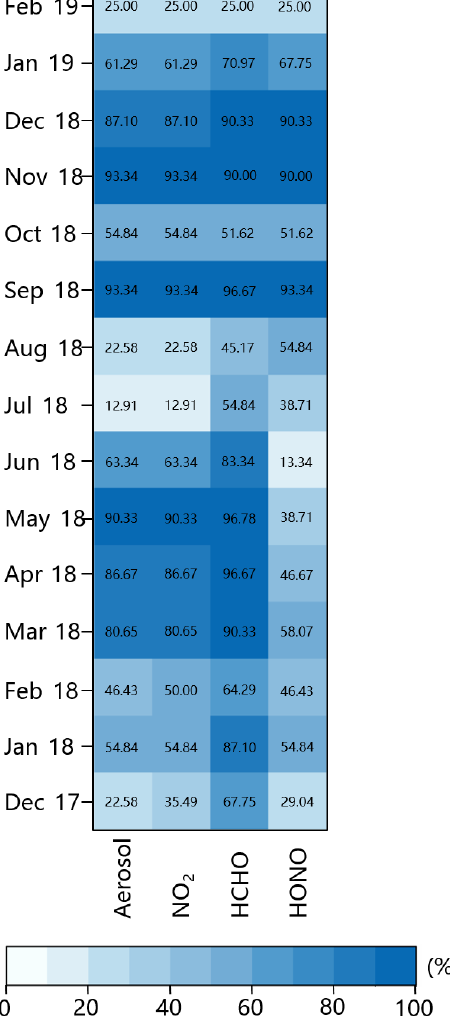
Figure 4. Monthly data integrity of the vertical profiles of aerosols, NO 2 , HCHO and HONO.